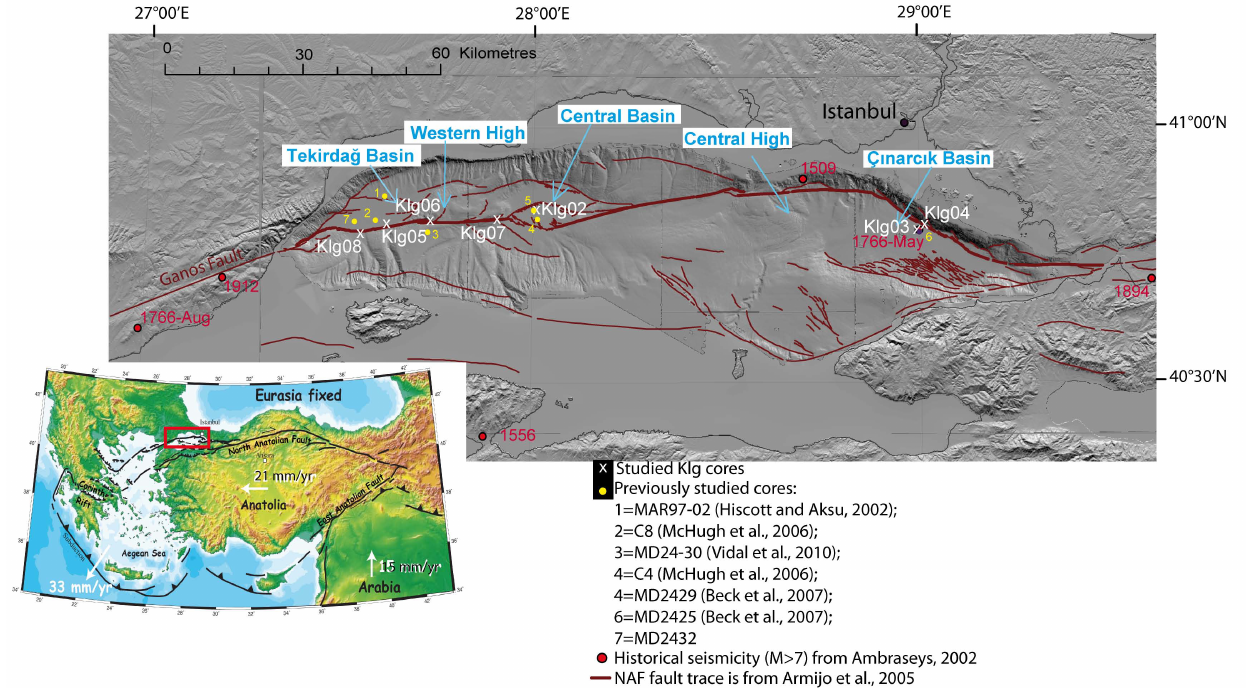
Fig. 1. General context of the Marmara Sea, crossed by the North Anatolian Fault (NAF). Main structures are labelled in blue. Global tectonic context of the Anatolian Plate is included as inset with GPS velocities from Reilinger et al. (2006), with a red box indicating the location of Fig.